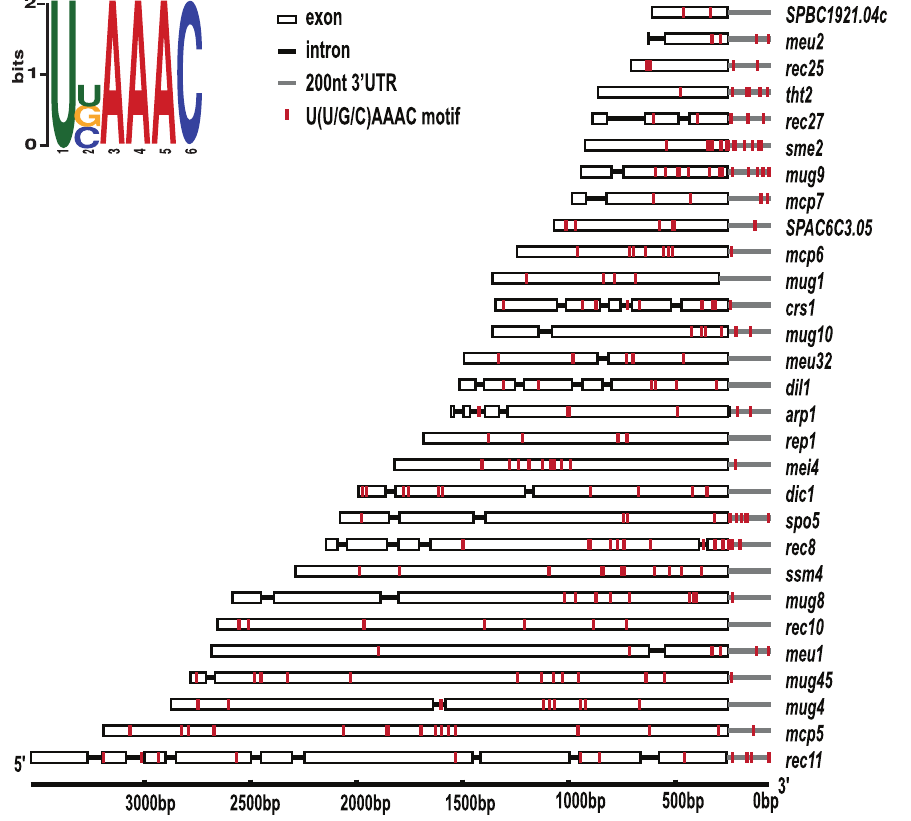
Figure 2. Putative Mmi1 binding motif. The sequence logo of the MEME predicted Mmi1 binding motif is shown on top left. The distribution of this motif (red bars) in the 29 Mmi1 regulated genes is drawn to scale.